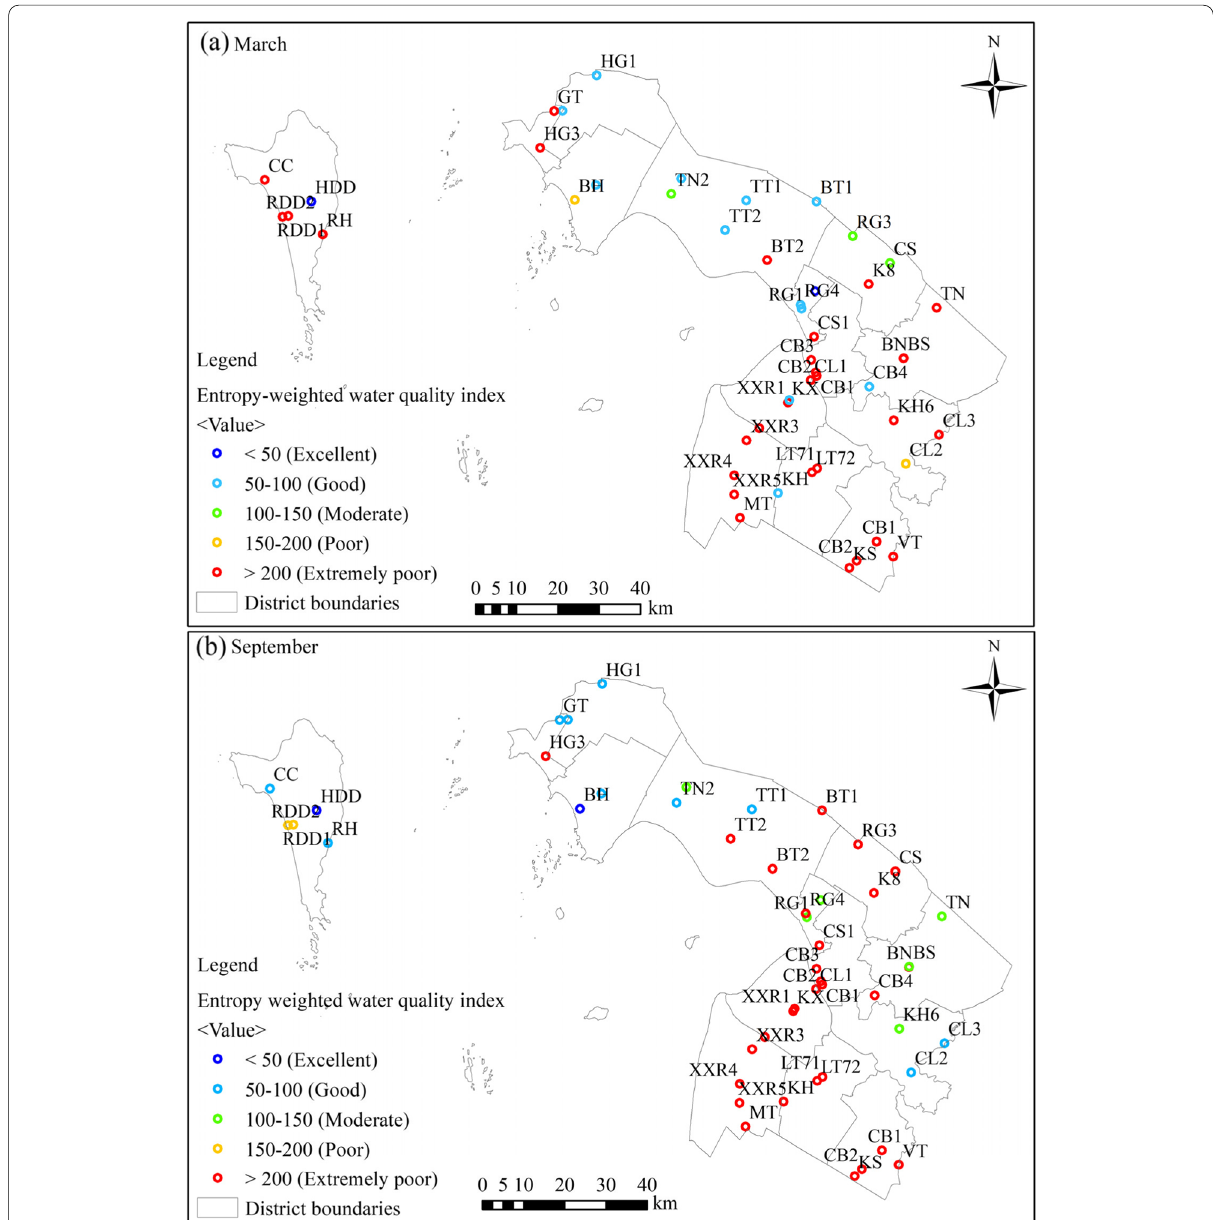
Fig. 7 Distribution of EWQI in ( a ) dry season and ( b ) rainy season in water